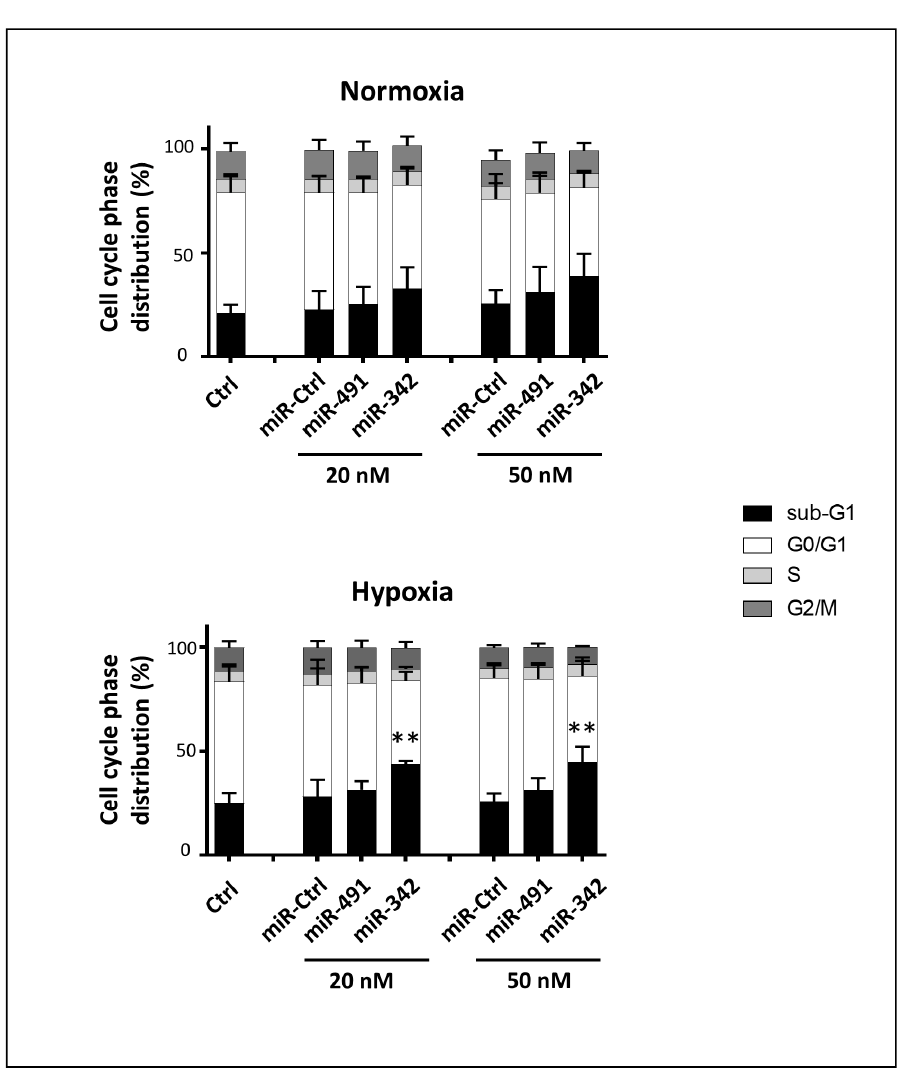
Figure 9. Effects of miR-491-5p and miR-342-5p on SW1353 cells cultured in 3D. SW1353 cells were cultured in collagen sponge scaffolds under normoxia or hypoxia. They were transfected 24 h after seeding with 20 nM or 50 nM of miR-Ctrl, miR-491-5p and miR-342-5p. Analyses were carried out 72 h post-transfection. Cell cycle phase distribution was analyzed using flow cytometry. The histograms represent the analysis of the different phases of the cell cycle of four independent experiments (mean ± SD). Statistically significant differences in the percentage of sub-G1 events between miR-Ctrl and miRNA-treated cells were determined using one-way ANOVA (**: p < 0.01).